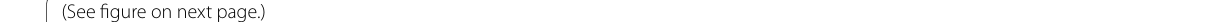
(See figure on next page.) Fig. 2 Graphical representation of the conserved motifs ( A )/domains ( B ) variations and their architecture in Eudicotyledons DCL protein sequence and their evolutionary relationship within each DCL protein clade. The protein motifs were obtained using MEME suit (http:// memes uite. org/ [1]) and the functional domains were predicted by querying the protein sequence in the Hmmscan search tool (https:// www. ebi. ac. uk/ Tools/ hmmer/ search/ hmmsc an [11]) against the Pfam database (http:// pfam. xfam. org/). Different motifs are represented by different colored boxes and the consensus sequences of the motifs are listed. The domains are marked with different shapes and